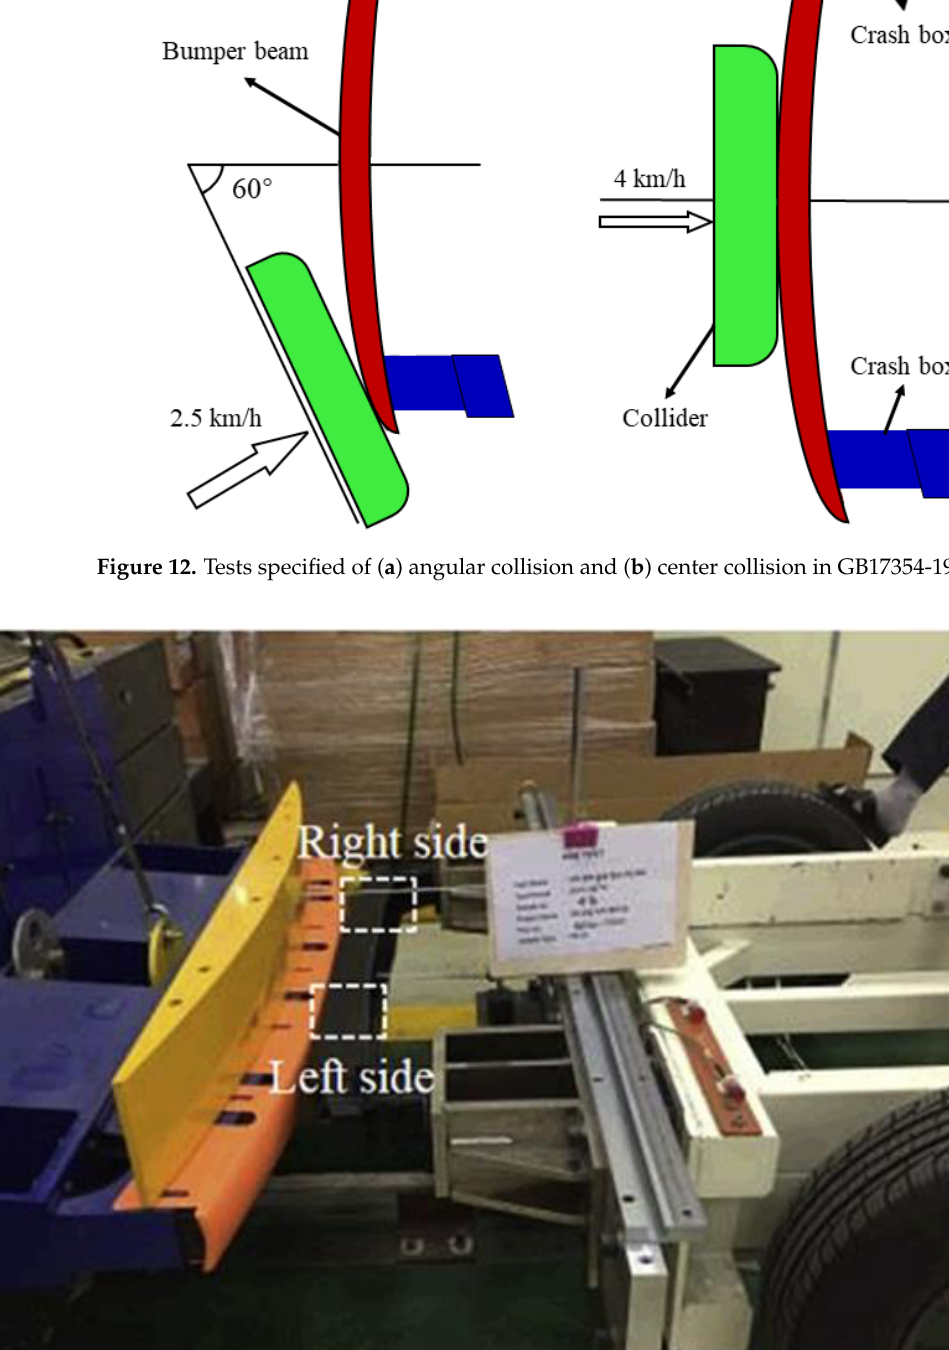
Figure 13. The glass fiber reinforced thermoplastic polypropylene (GFPP) bumper beam impact test [36].